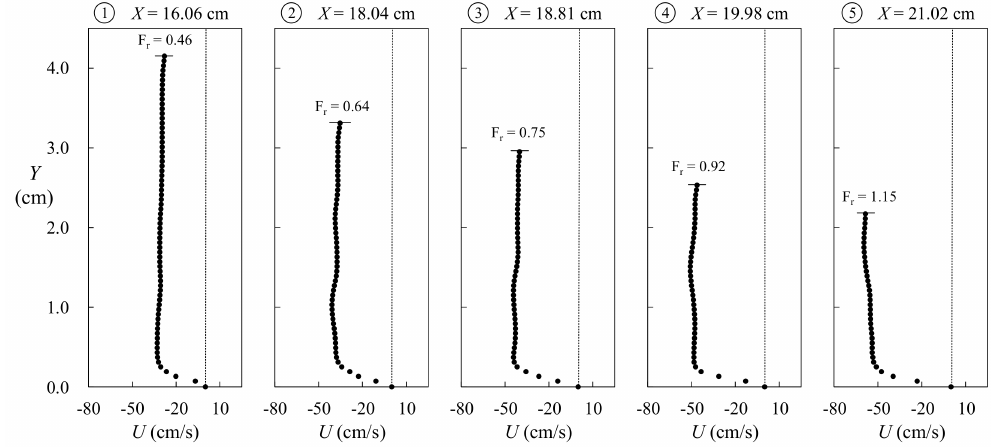
Figure 10. Velocity profiles, U ( Y ), measured at five different positions for t = 0.813 s (Case